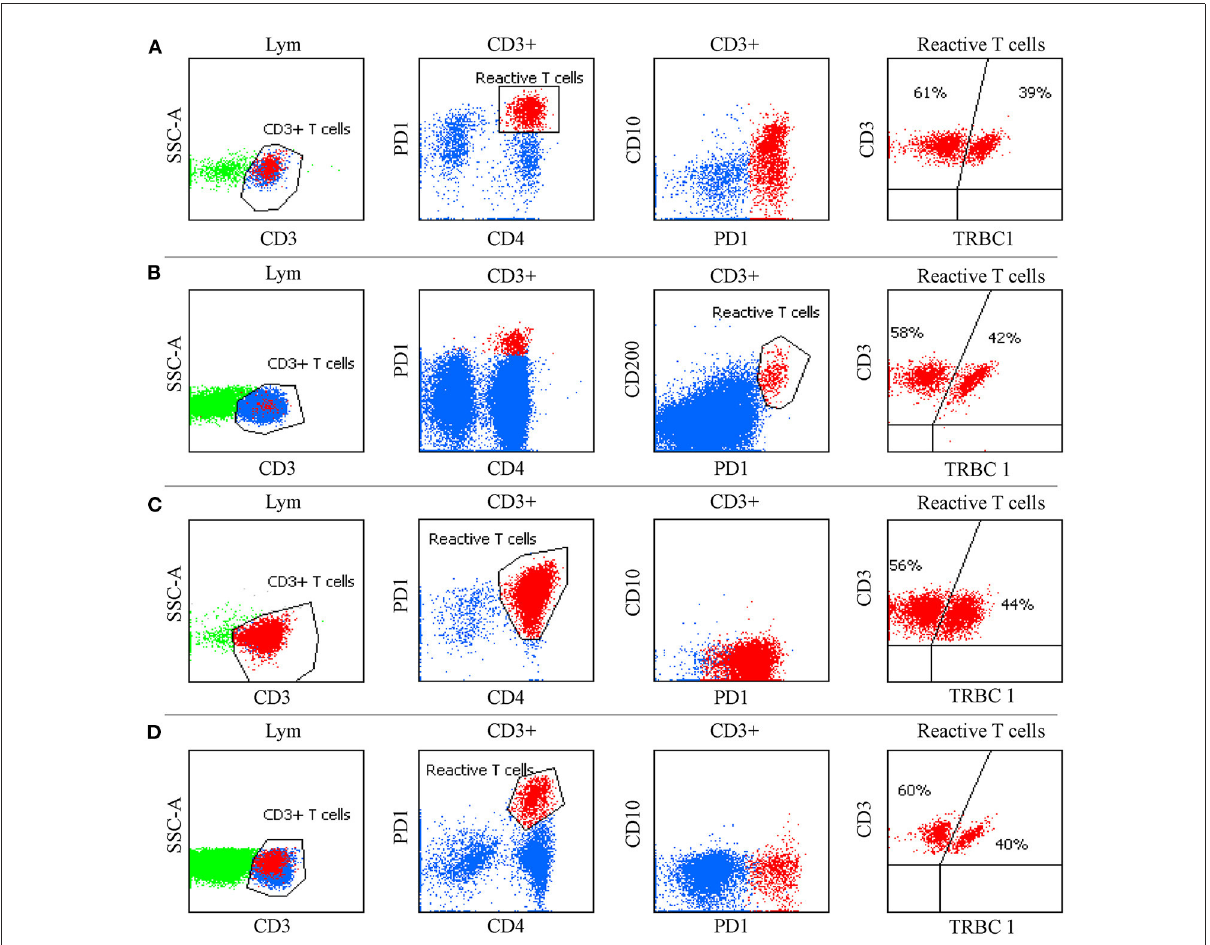
FIGURE4 Flow cytometric findings in non-T cell lymphoma. (A) CD4 + T cells with CD10 and bright PD-1 expression were observed in follicular lymphoma. (B) CD4 + T cells with CD200 and bright PD-1 expression were seen in tuberculous granuloma. (C) Expansion of CD4 + T cells with bright PD-1 expression was present in nodular lymphocyte-predominant Hodgkin lymphoma. (D) CD4 + T cells with distinctive bright PD-1 expression were observed in reactive follicular hyperplasia. TRBC1 was polyclonal in these